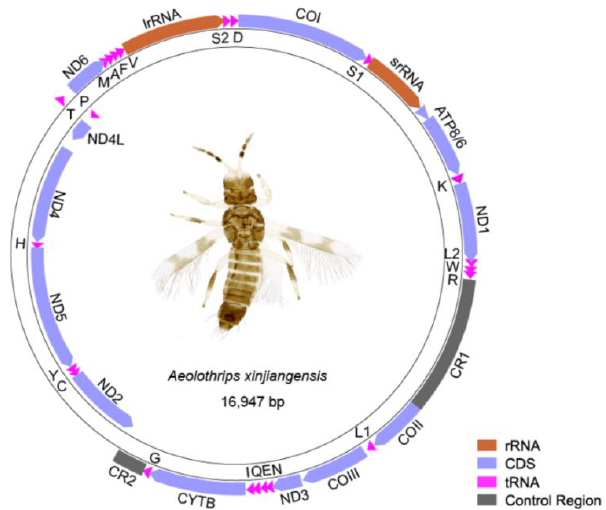
Figure 1. The mitogenome of Aeolothrips xinjiangensis . DNA strands are shown as two thick-lined circles. The direction of gene transcription is indicated by the arrows. Abbreviations: ATP6 and ATP8 , adenosine triphosphate (ATP) synthase subunits 6 and 8; COI – COIII , cytochrome oxidase subunits 1 – 3; CYTB , cytochrome b; ND1 – 6 and ND4L , nicotinamide adenine dinucleotide hydrogen (NADH) dehydrogenase subunits 1 – 6 and 4L; srRNA and lrRNA , large and small rRNA subunits. Transfer RNAs are represented by their amino acid abbreviation of the corresponding amino acid, for transfer RNA (L1: CUN; L2: UUR; S1: UCN; S2: